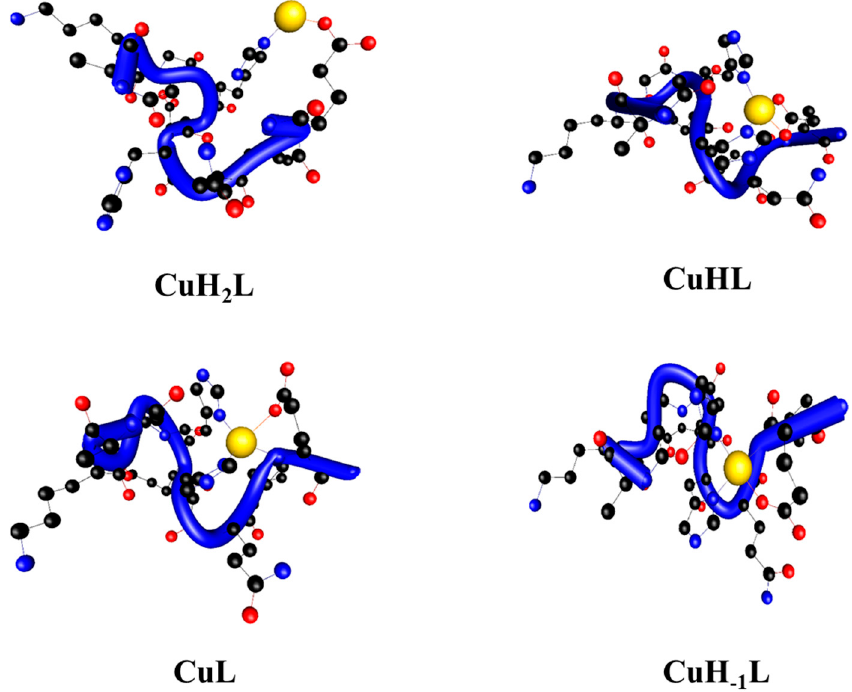
Figure 2. The structures of Ac-AKGHEHQLE-NH 2 complexes with Cu(II), where blue tubes follow backbones.